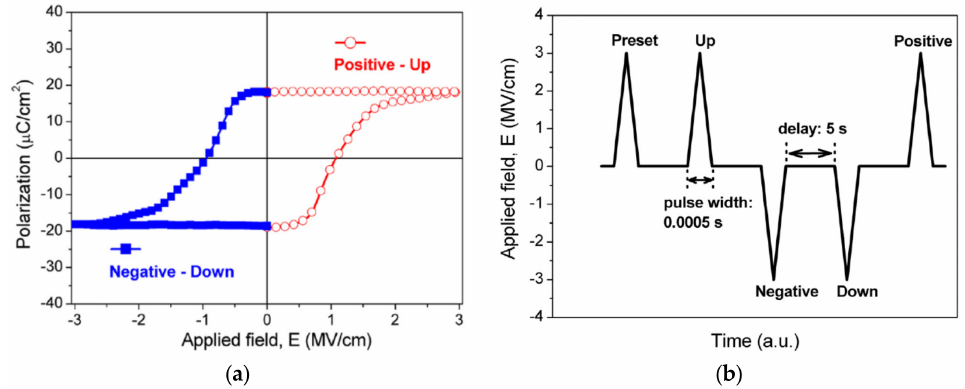
Figure 5. ( a ) Example of P–V hysteresis obtained with the PUND method and ( b ) schematic diagram of electric field pulses in the PUND test. Reproduced with permission [75]. Copyright 2015, Elsevier Ltd.